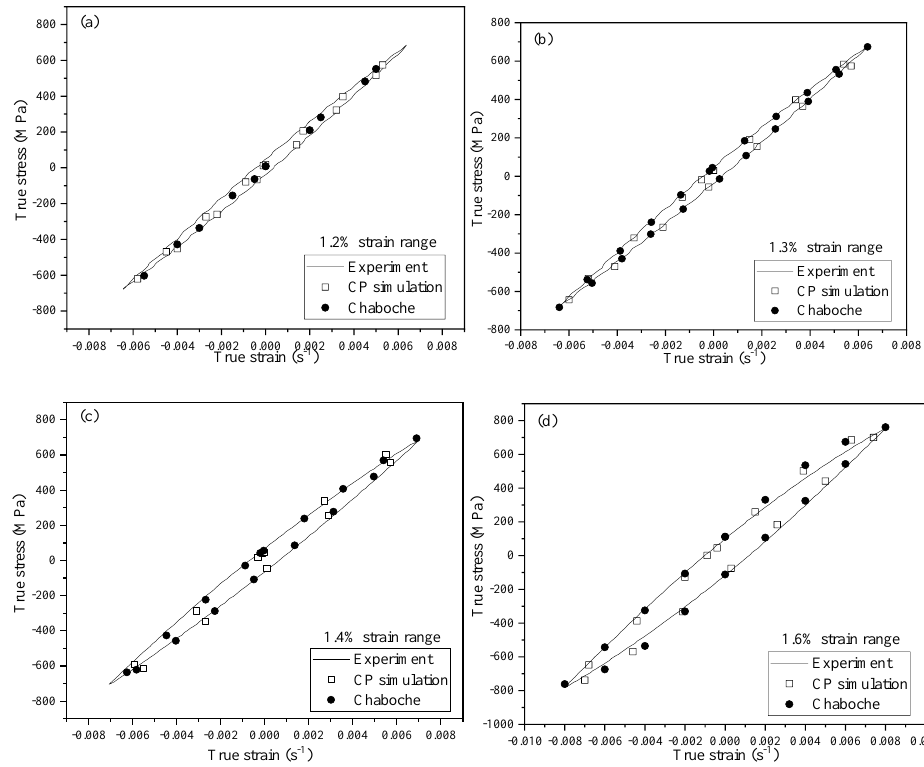
Figure 8. Stress – strain curves of experiment, CP simulation and Chaboche model: ( a ) 1.2% strain range; ( b ) 1.3% strain range; ( c ) 1.4% strain range; and ( d ) 1.6% strain range.